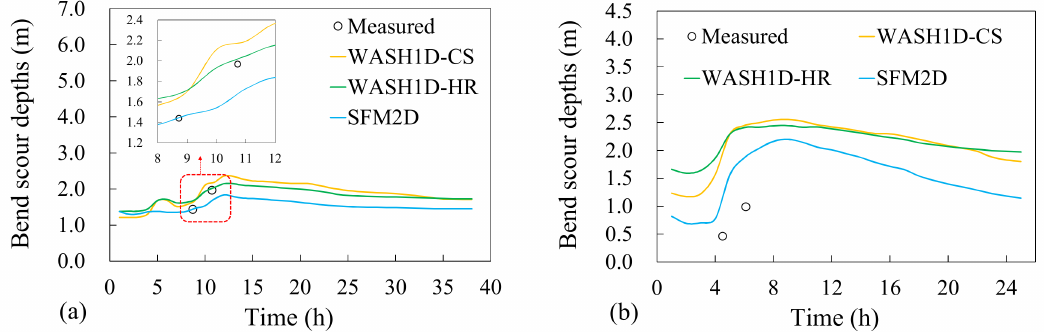
Figure 14. Comparisons of the measured and simulated bend scour depths obtained using three